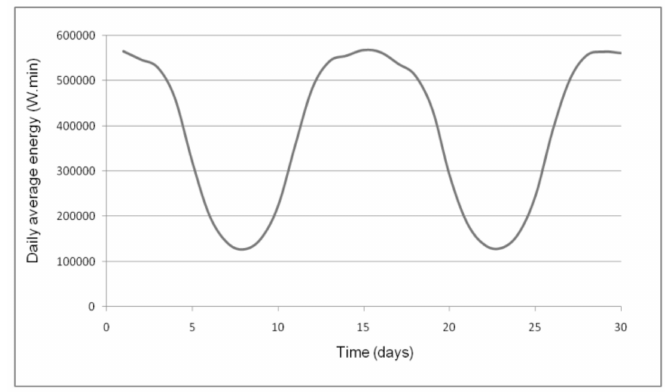
Figure 4. Daily average extracted energy